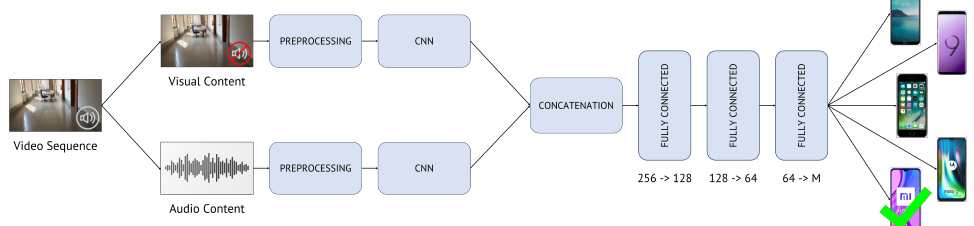
Figure 6. Early Fusion method pipeline. Given a query video, we extract and pre-process its visual and audio content. Then, we feed these data to one multi-input CNN, composed of two CNNs whose last fully-connected layers are concatenated. Three additional fully-connected layers follow to identify the actual source camera